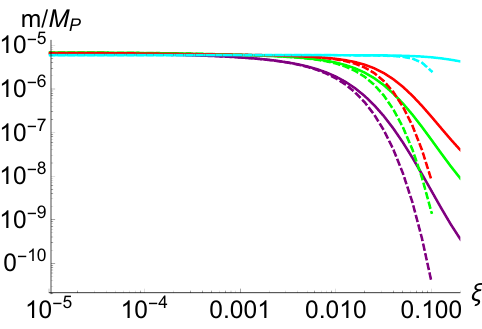
Figure 10. m vs. ξ for δ = 40 , 70 , 100 , 1000 respectively in purple, green, red and cyan with N e = 60 e -folds in region 2. Continuous/dashed line represents metric/Palatini